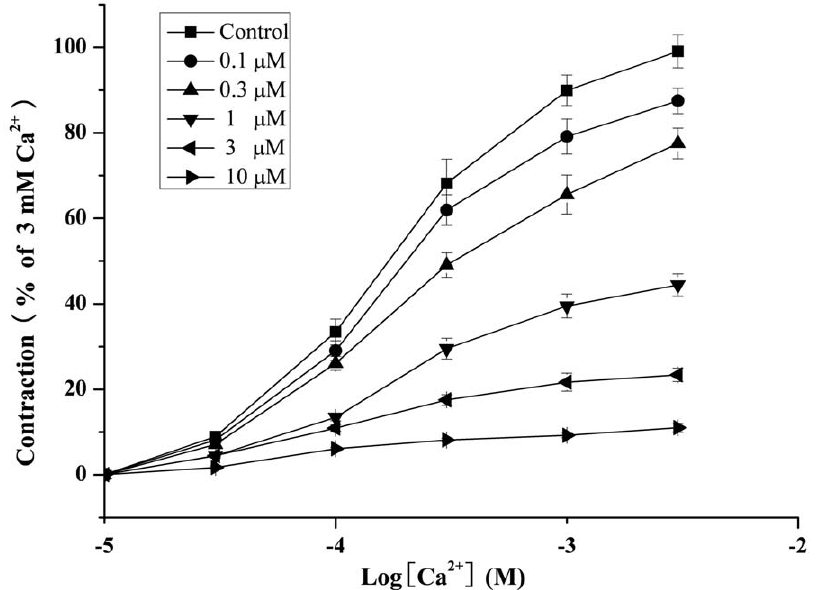
Figure 4. Cumulative concentration-response curves for Ca 2 + in the presence of the vehicle and increasing concentrations of 16c (0.1–10 m M) in isolated endothelium-intact aortic rings (n=5). Results are the mean 6 S.E. from 5 independent experiments.